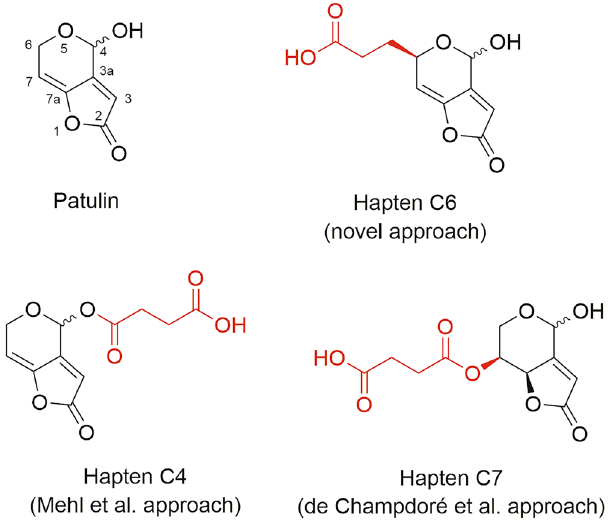
Figure 1. Chemical structures of patulin (showing numbering of carbon atoms) and conventional haptens used in this work for antibody